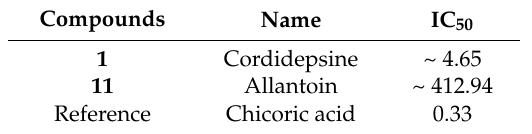
Table 3. Anti-HIV-1 integrase activity (IC 50 in µ M) of isolated compounds 1 and 11.